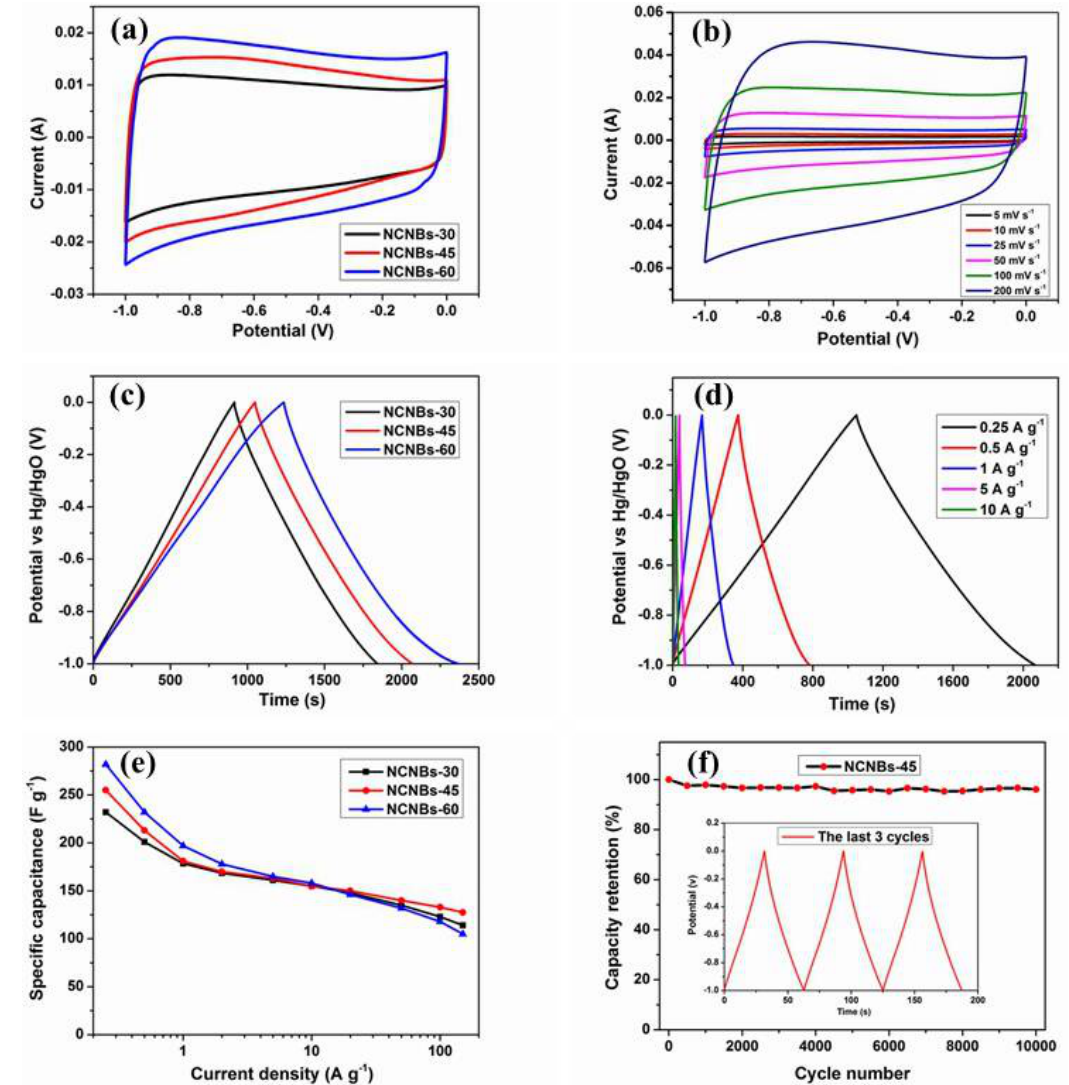
Figure 6. ( a ) the CV curves of NCNBs at a scan rate of 50 mV s −1 ; ( b ) CV curves of NCNBs-45at different scan rates; ( c ) GCD cures of NCNBs at 0.25 A g −1 ; ( d ) Galvanostatic charge-discharge curves at different current densities of NCNBs-45; ( e ) Specific capacitance of NCNBs electrodes at different current densities; ( f ) Cycle stability of NCNBs-45electrode at 5 A g −1 .